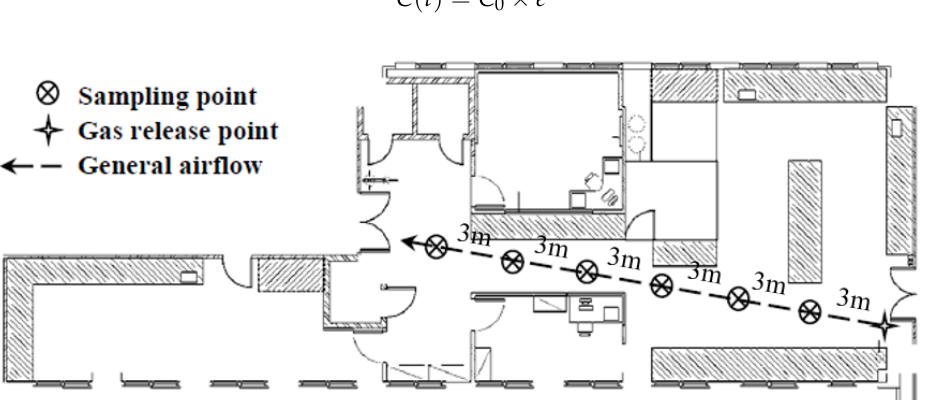
Figure 3. Layout of the testing laboratory with sampling and gas release point locations for system response time evaluation.